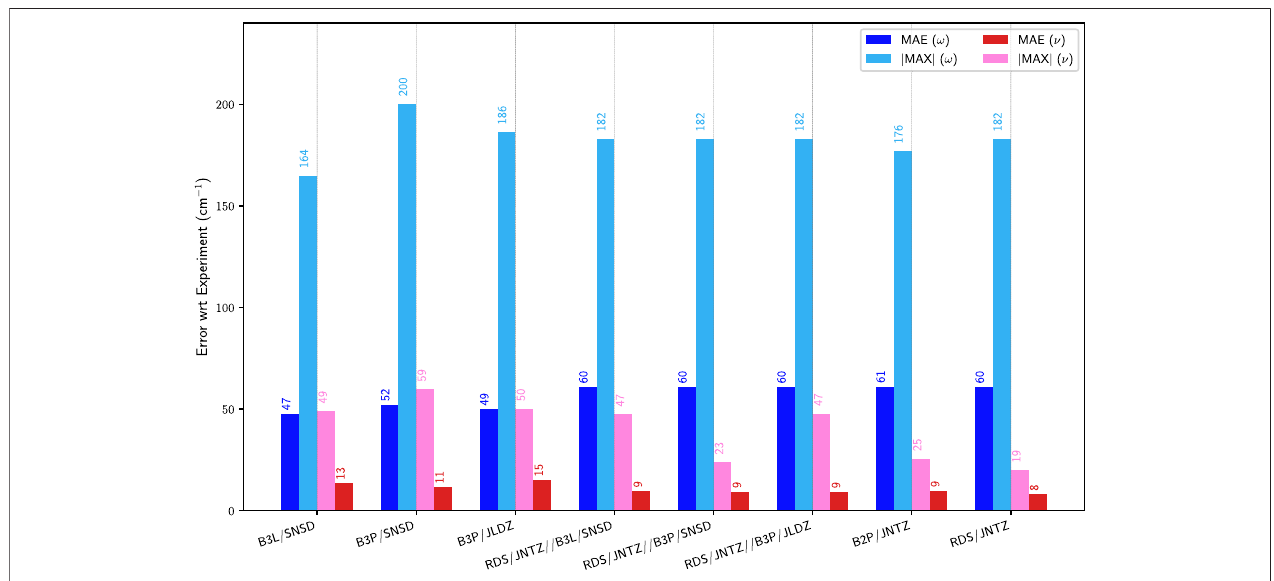
FIGURE4| Comparisonofthemean(MAE)andmaximumabsolute(|MAX|)errorsofpurefunctionalsandhybridmodelsoverthe fi rstsetofmolecules(G1). ω (blue) corresponds to the harmonic approximation, ν (pink/red) to GVPT2. The values are indicated on top of the bars. The hybrid models are built by combining harmonic calculations with double hybrid functionals, with anharmonic force fi elds at a lower level, and noted “ harmonic//anharmonic ” . See Figures 2 , 3 for details on the abbreviations and the reference data used.